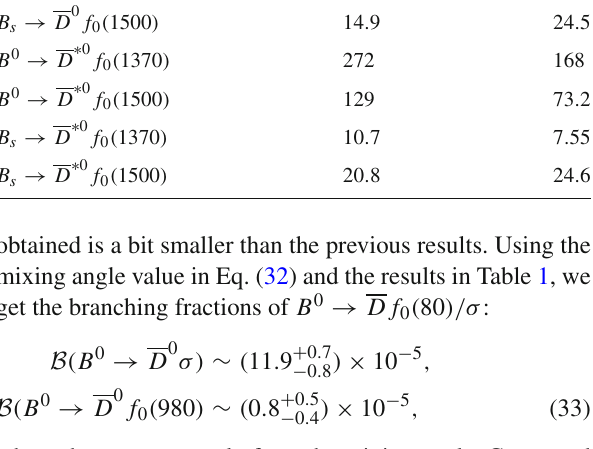
Table 6 The calculated branching fractions of B ( s ) → D and f 0 ( 1500 ) with the mixing in the PQCD approach (unit:10 − 6 ) Decay modes S1